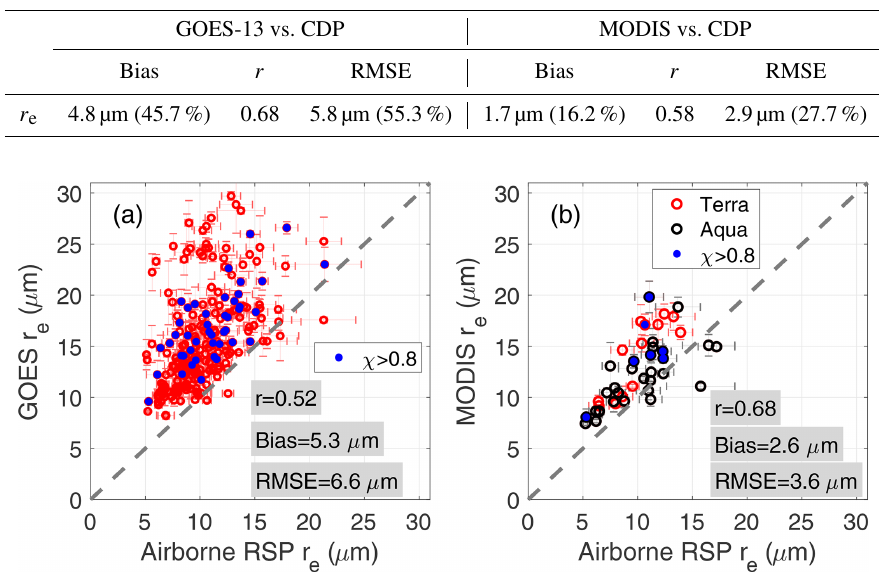
Figure 5. Relationship between airborne RSP r e and (a) GOES-13 and (b) MODIS. Statistics for MODIS combine data from Aqua and Terra. Error bars denote the spatial standard deviation. Blue circles denote retrievals derived over highly heterogeneous cloud